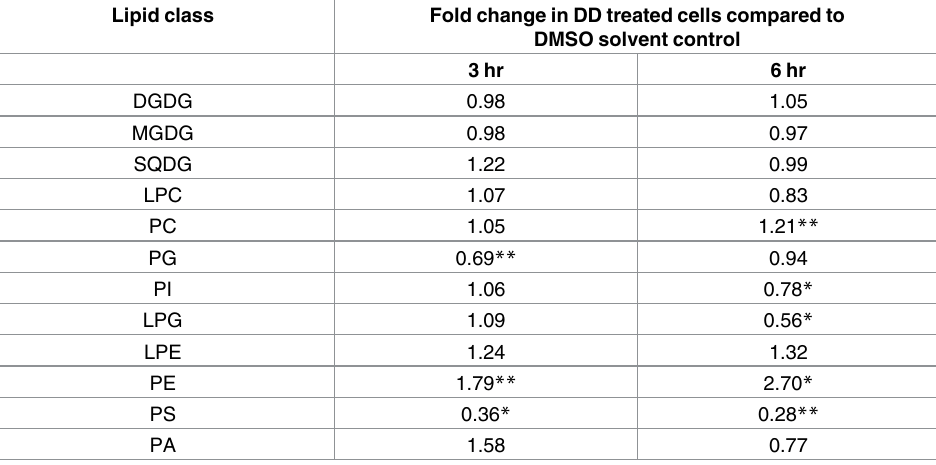
Table 4. Fold changes in lipid classesin DD treated P . tricornutum cells compared to DMSO solvent control. Data represent fold changescalculatedfrom 5 bio reps of each DMSO and DD treated cultures; ** p < 0.05; * p < 0.1determined by student’s t-test based on Table 3 in comparisonto the